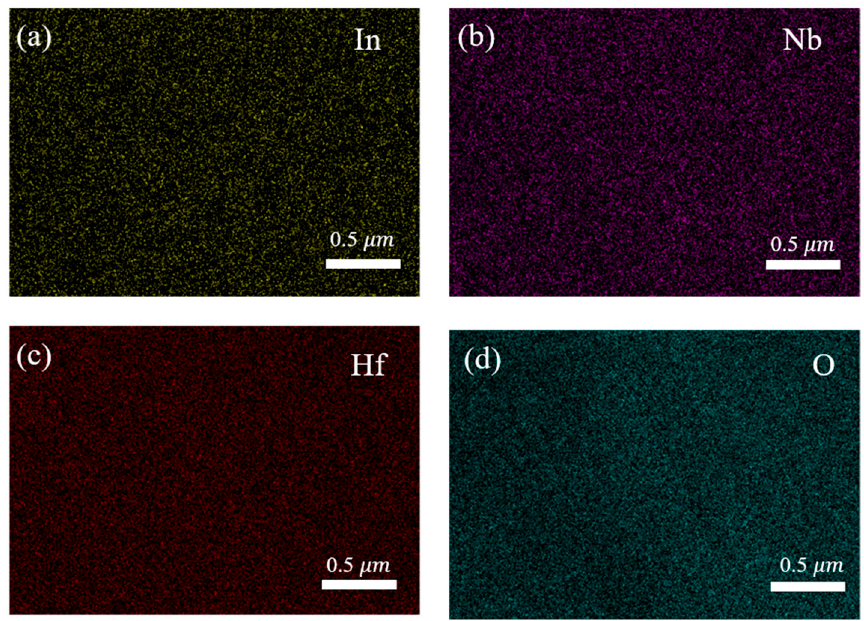
Figure 7. Elemental mappings of ( a ) In, ( b ) Nb, ( c ) Hf, and ( d ) O.